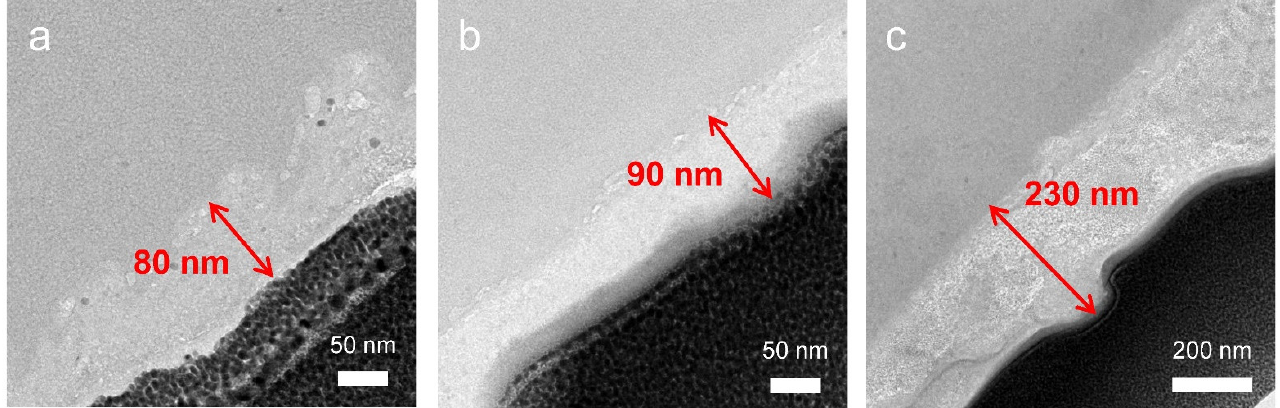
Figure 4. Cross-sectional TEM images of SiOx blending electrode after ( a ) 50 cycles, ( b ) 100 cycles, and ( c ) 250 cycles.